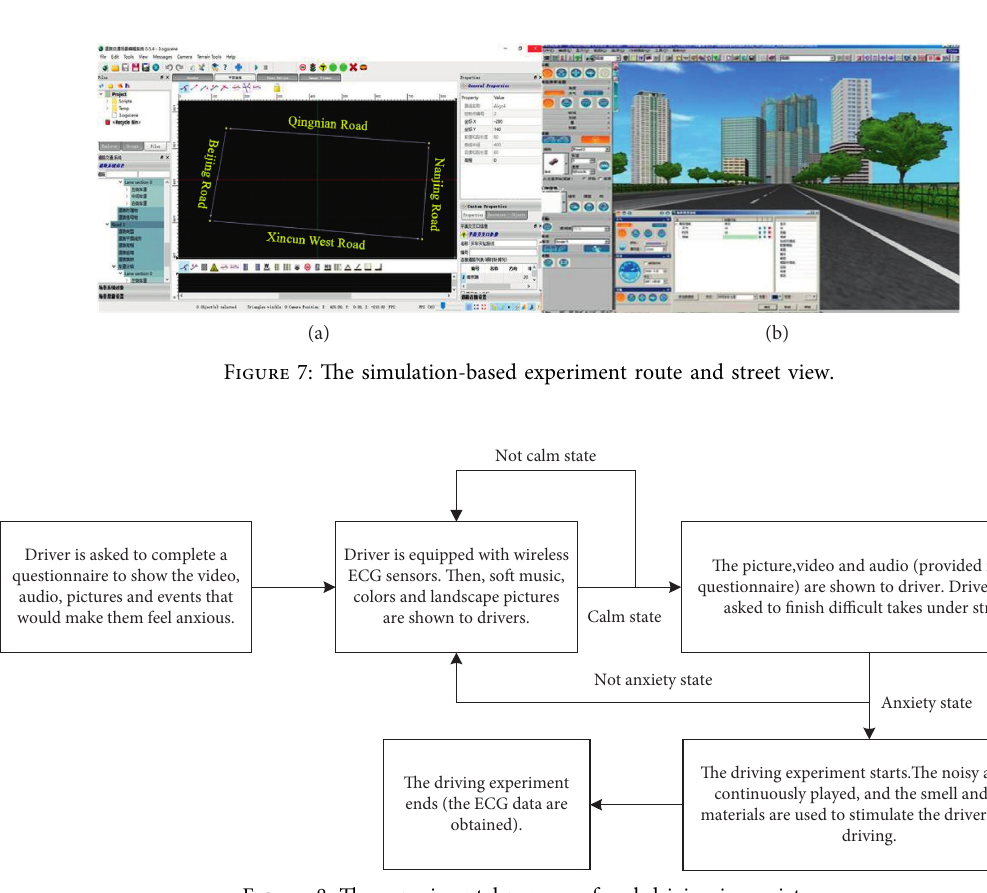
Figure 6: The wearable wireless ECG sensors.